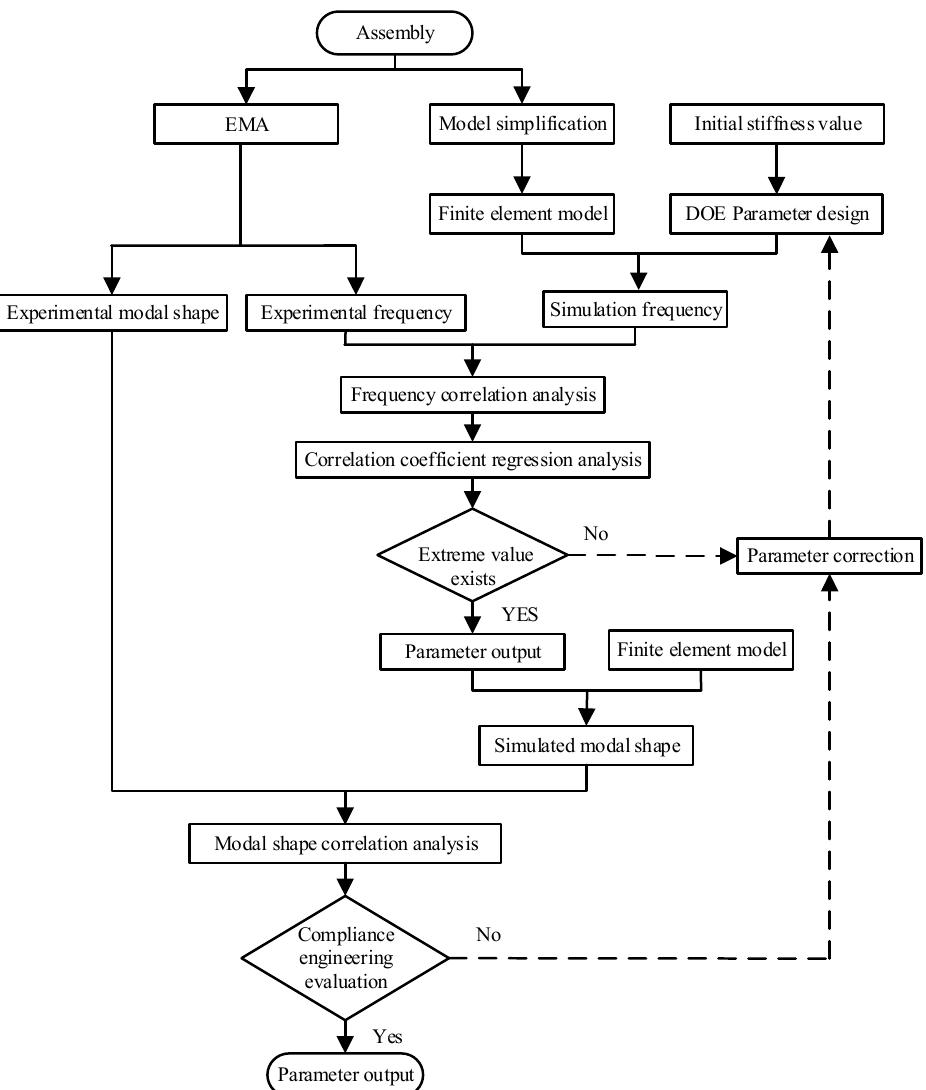
Figure 4. Flowchart of inverse identification for the parameters of joints.